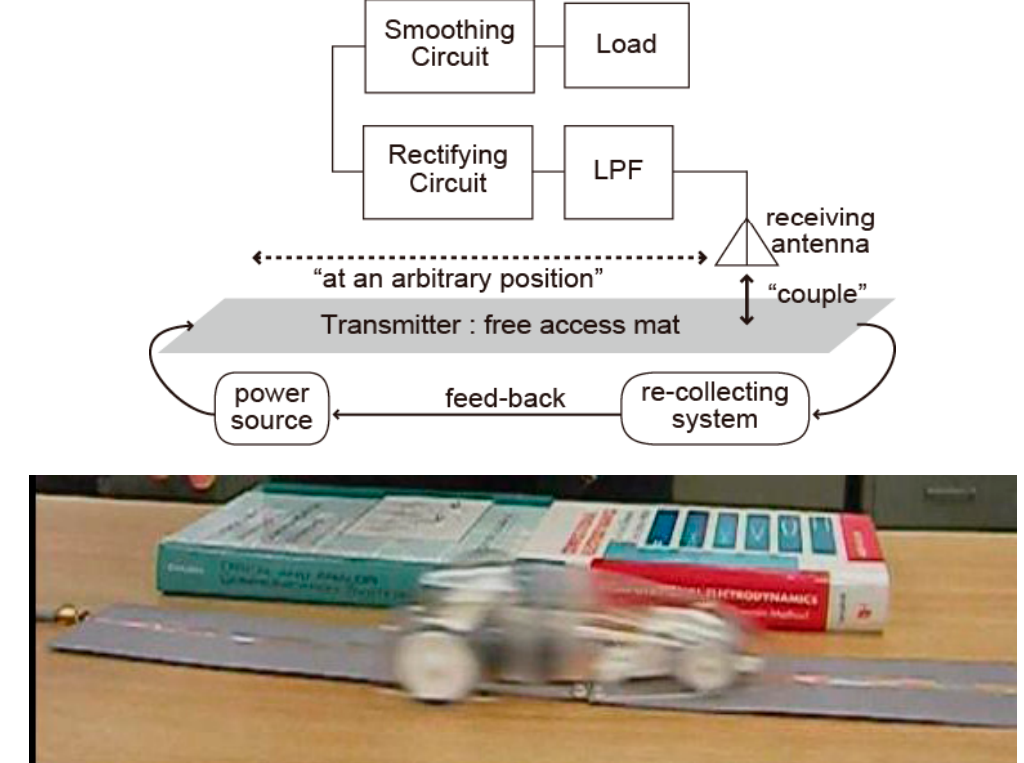
Figure 6. Power transmission by one-dimensional transmission line.